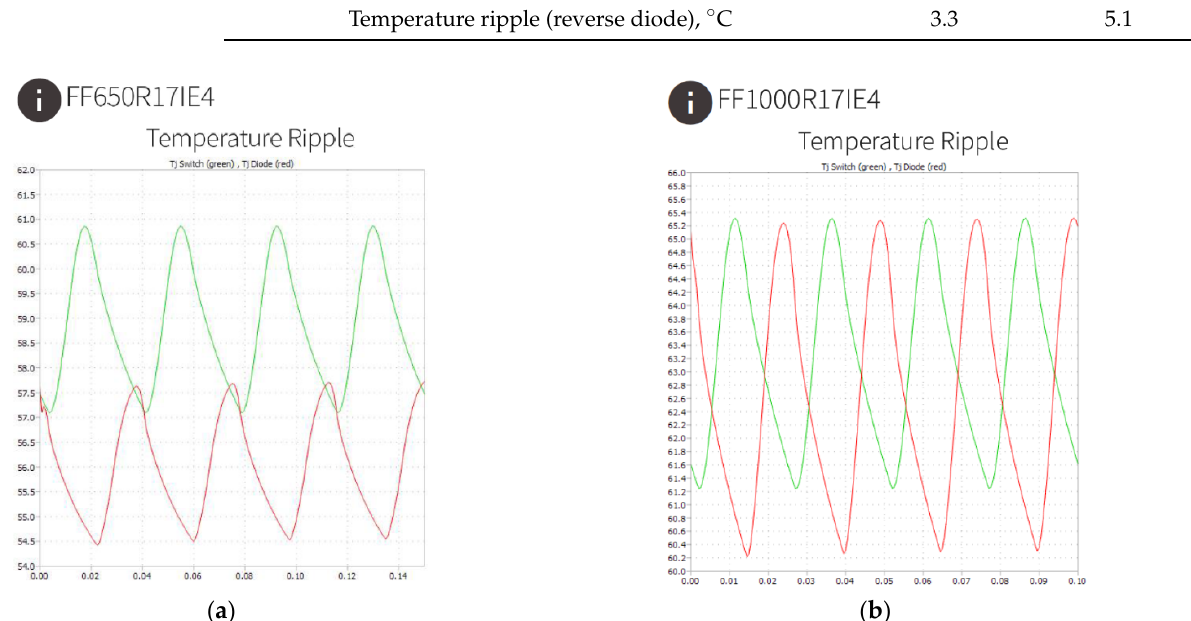
Figure 8. Plots of the temperature of the inverter elements when feeding various motors in time. Green line is for IGBT; red line is for reverse diode. ( a ) WRSM employing FF650R17IE4 modules; ( b ) SHM employing FF1000R17IE4 modules.